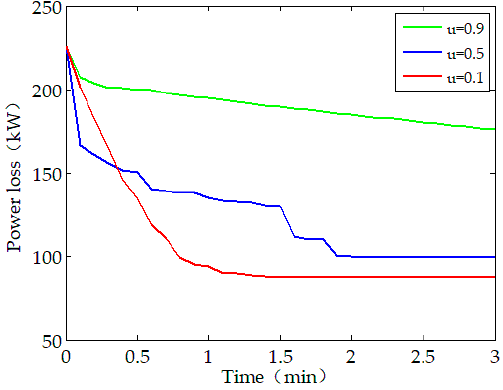
Figure 5. Sensitivity of smoothing coefficient μ under Scenario A.